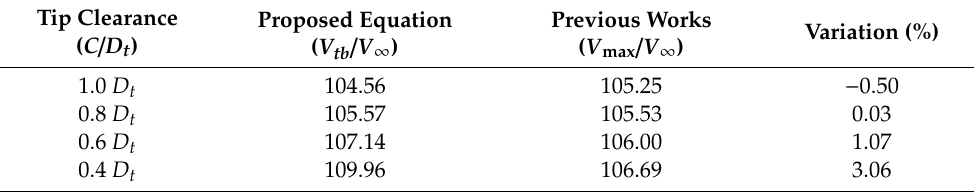
Figure 5. Comparison of predicted tip-bed velocity with previous research. Table 1. The tip-bed velocity of our proposed equation and previous